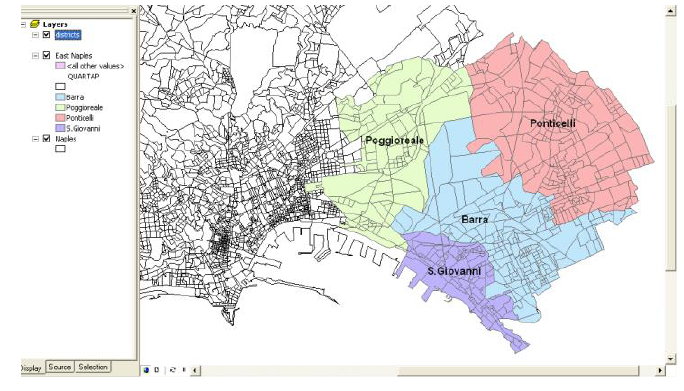
Fig. 2. Area of study: four districts at east of Naples (Italy) Table 1. Values of the TFNs low, mean, high Output